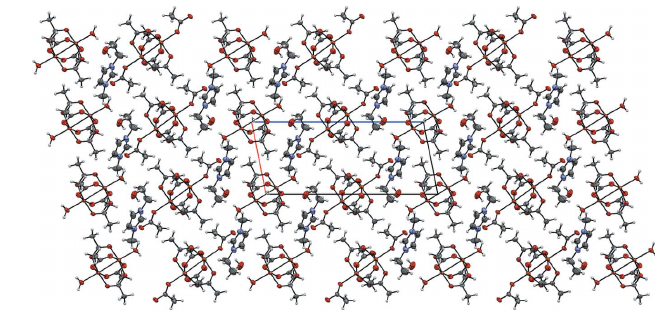
Figure 7 The packing of compound 3 , viewed along the b axis.